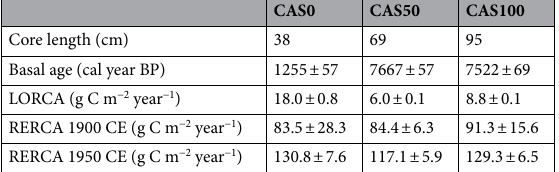
Table 1. Long-term apparent rate of C accumulation (LORCA) and recent apparent rate of C accumulation (RERCA) data for the three study sites.